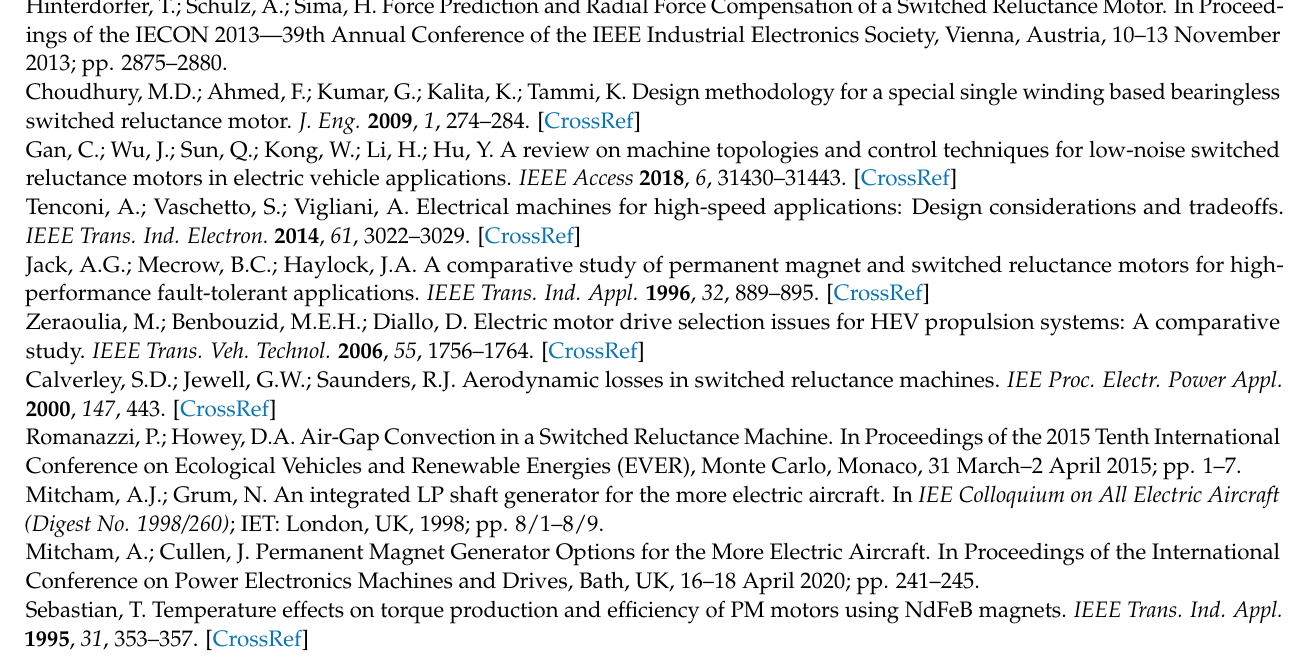
In the rotor and stator poles, the problem is the same as in the air gap. Therefore, the same solution could be applied and the pole surface is meshed with a gradient in which the element size near the air gap is smaller than near the yoke. Another point taken into account is the poles zones between different packages (in the skewed rotor simulation) where the gradient is very high and the magnetic path in the axial direction (in a particular angular position) could be different due to the variable skewing angles of the packages and also the air gap. In these cases, the element size needs to be very small to calculate the gradient of the magnetic field with the enough